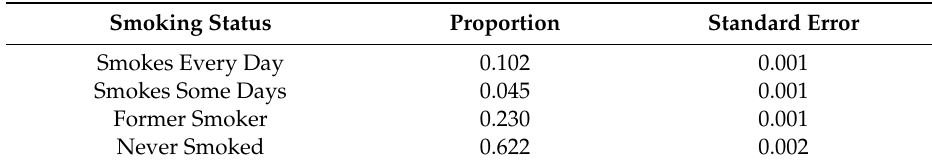
Table 6. Variable SMOKER3: “Four-level smoker status: Everyday smoker, Someday smoker, Former smoker, Non-smoker [20]”.